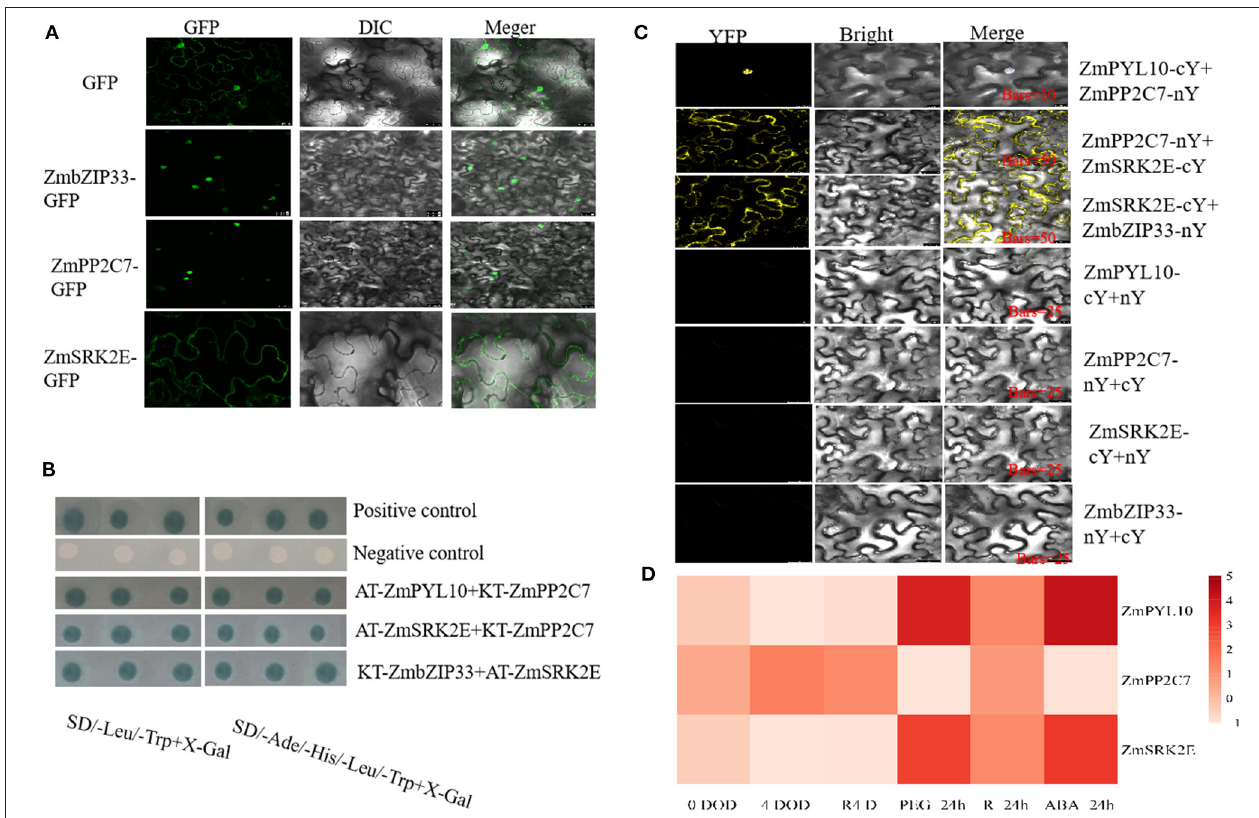
FIGURE 8 | Interaction analysis of ZmbZIP33, ZmPP2C7, ZmSRK2E, and ZmPYL10 and their expression patterns under drought stress and rewateing. (A) Fusion proteins were transiently expressed under the control of CaMV35S promoter in tobacco leaves and were subsequently observed under a laser scanning confocal microscope. Bars = 25 µ m. (B) The pGADT7-T + pGBKT7-Lam and pGADT7-T + pGBKT7-53, as negative and positive controls, respectively. (C) The nYFP and cYFP represent pSAT4-nEYFP and pSAT4-cEYFP vectors, respectively. When an interaction relationship was verified, DAPI (nuclear marker) staining was selected. The interaction signal of ZmPYL10-cY and ZmPP2C-nY coincided with DAPI, indicating an interaction within the nucleus. (D) The expressions of ZmPP2C7 , ZmSRK2E, and ZmPYL10 in BMV and BMV-ZmbZIP33 under drought stress for 0 days (0 DOD) and 4 days (4 DOD), and rewatering for 4 days (R4D) were measured. And the response patterns of ZmPP2C7 , ZmSRK2E, and ZmPYL10 to drought stress (PEG-24h), rewatering (R-24h) and ABA (ABA-24h, 5 µ mol/L) treatments for 24h were measured. Using maize 18S as an internal control, the relative expression was determined by 2 − 11 Ct0h to